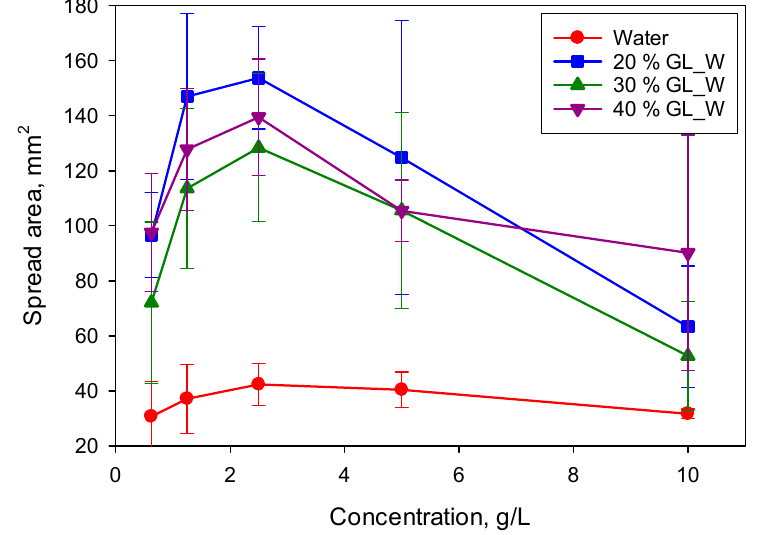
Figure 7. Dependence of the spread area on PE at t = 14 s on concentration of BT-233 in various aqueous solvents.